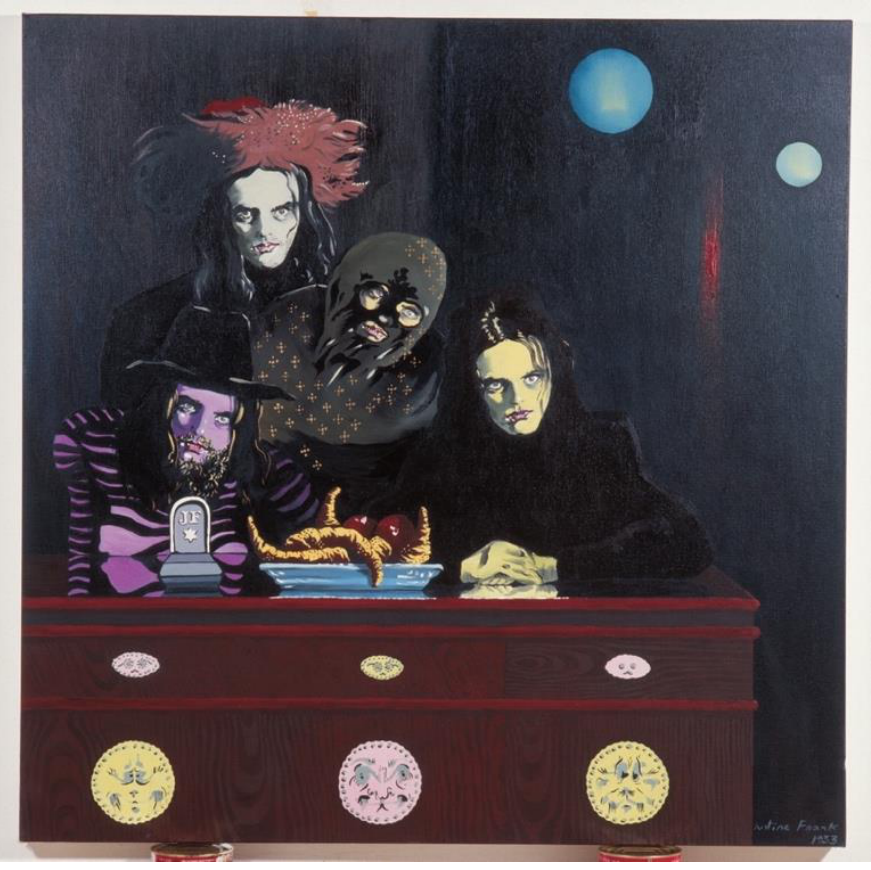
Figure 21. Justine Frank, Frank’s Guild , 1933, oil on canvas, 100 × 100 cm. Courtesy of the artist.